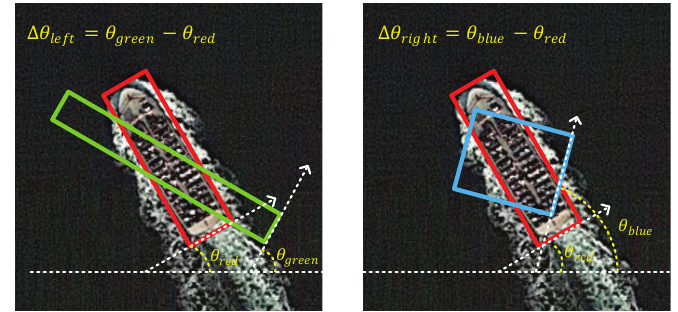
Figure 11. For this ship, the red rectangle indicates a better inference result with a score of 0.9. The green rectangle has the same area as the blue one, and they are also the inference results before the non-maximum suppression (NMS) processing, with scores 0.8 and 0.6. When using the five-parameter coordinates, ∆ θ left represents the rotation angle between the green bounding box and the red rectangle, and ∆ θ right represents the rotation angle between the blue bounding box and the red rectangle. By using Equation (5), we can obtain a result where the rotated _ IoU left < 0.5 ≤ rotated _ IoU right even if both the blue and green boxes should be removed in the same iteration.